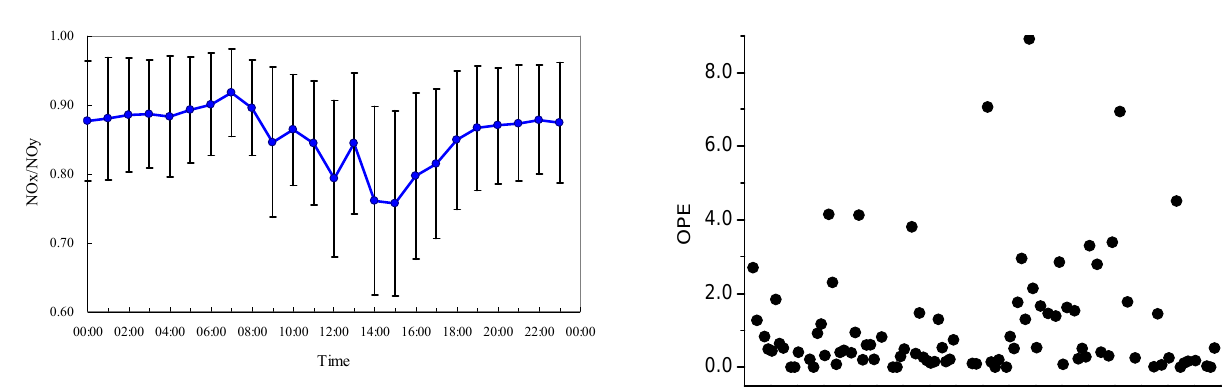
age OPEx in winter for an urban site in the megacity